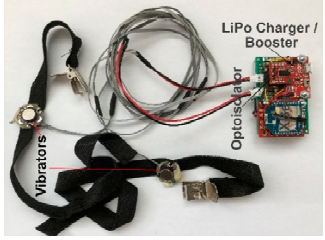
Figure 5. Prototype receiver.